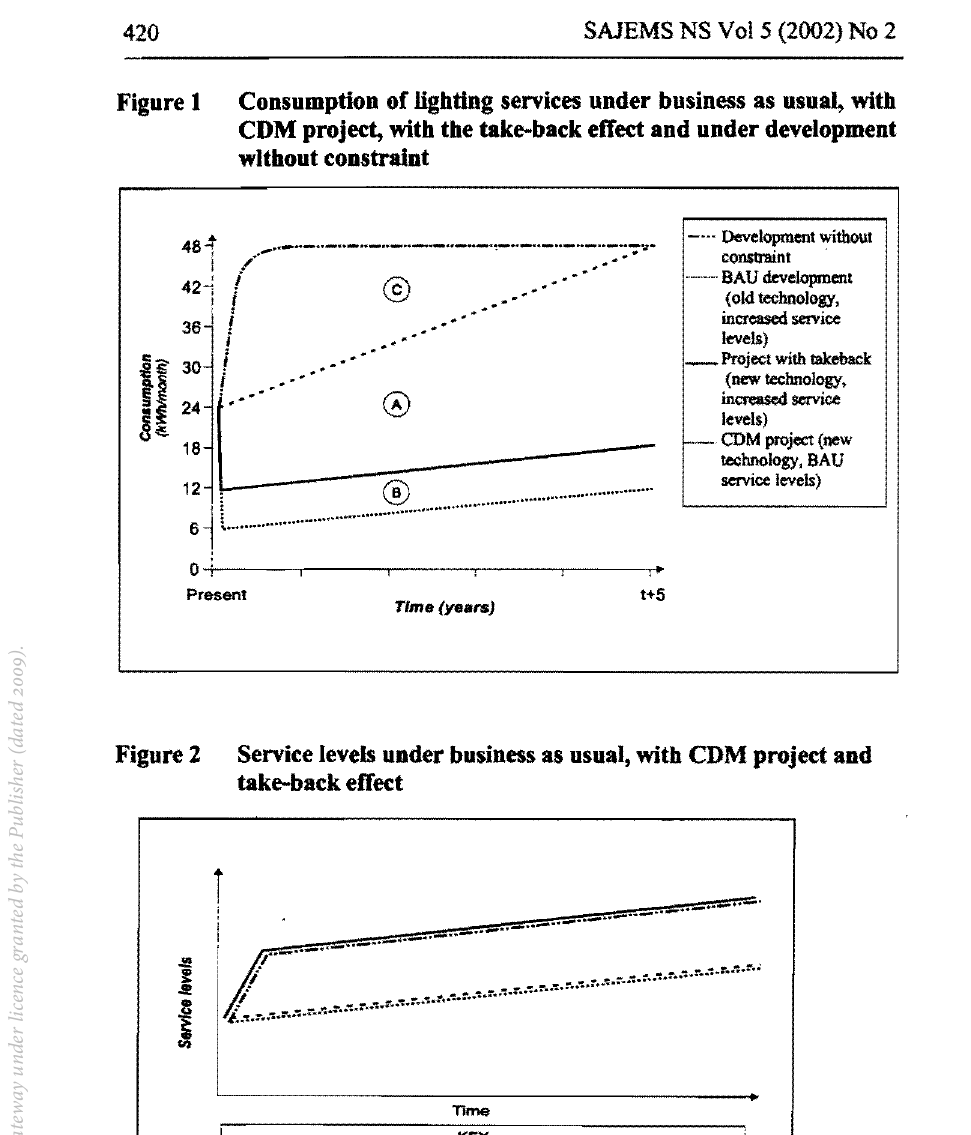
Consumption of lighting services under business as usual, with CDM project, with the take-back effect and under development without constraint